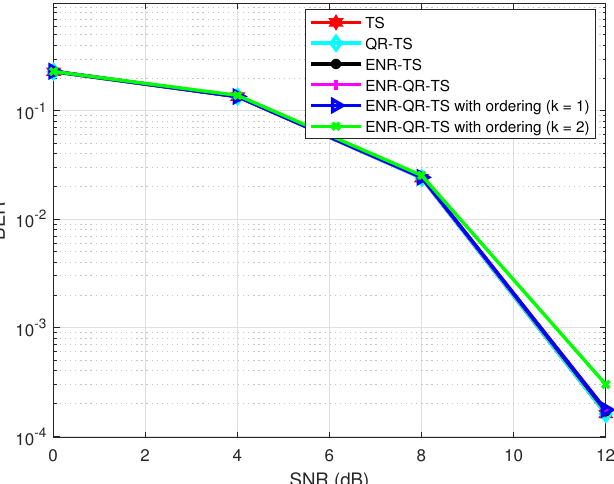
Figure 2. Comparison of the BER performance of TS algorithms for a 16 × 16 MIMO system with